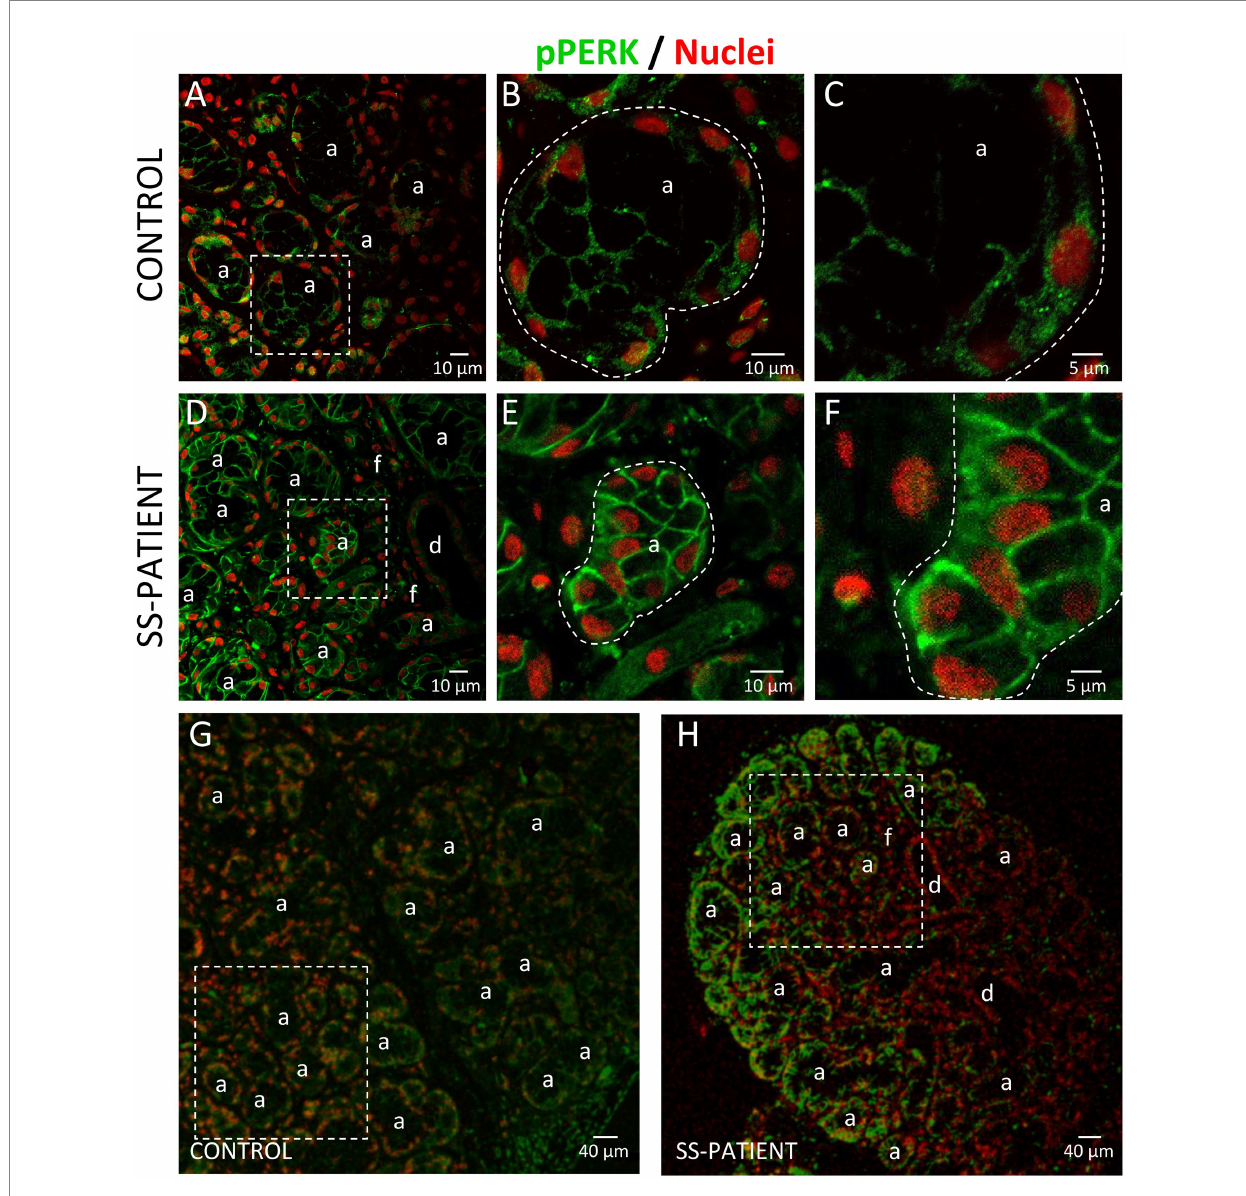
FIGURE 7 Localization of p-PERK in LSGs from control and SS-patients. (A–C,G) p-PERK (green) staining was mainly observed in the basolateral cytoplasm of epithelial cells in LSGs from control subjects. (D–F,H) Stronger p-PERK (green) staining was observed in the basolateral cytoplasm and plasma membrane of epithelial cells in LSGs from SS-patients. (A,D) higher magnifications of regions surrounded by broken lines in G and H, respectively. (B,C,E,F) Higher magnifications of regions surrounded by broken lines in A and B, respectively. Nuclei (red) were counterstained with Hoechst-33342. a: acini; d: duct; f: focus of inflammatory cells. Bars A, B, D and E: 10 μ m; C and F: 5 μ m; G and H: 40 μ